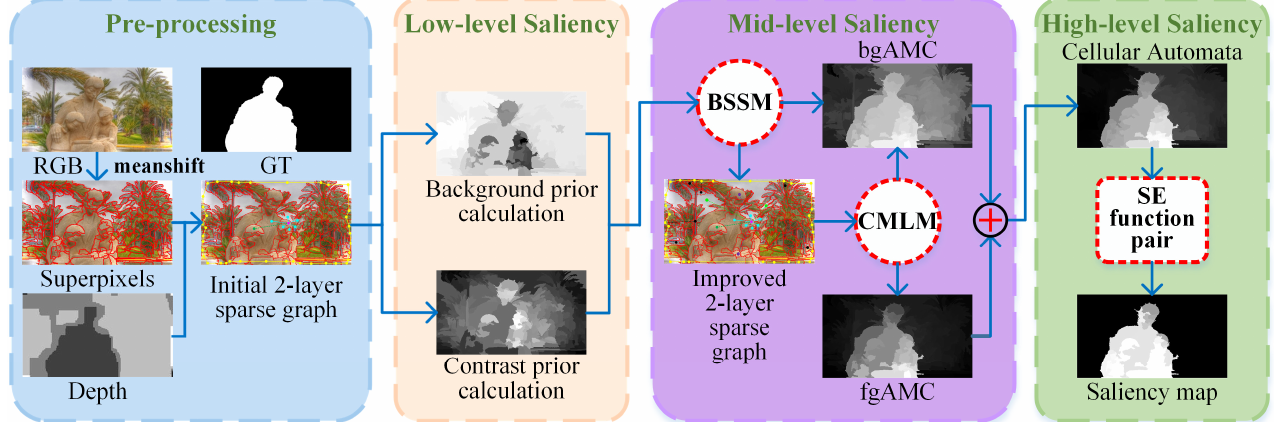
Figure 1. Flowchart of the proposed method. BSSM: background seed screening mechanism; CMLM: cross-modal multi-graph learning model; bgAMC and fgAMC denote background-based and foreground-based saliency maps based on absorbing Markov chain respectively; SE function pair represents suppression-enhancement function pair.